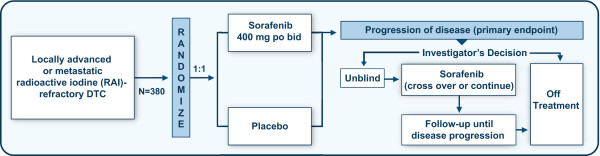
DECISION schema.